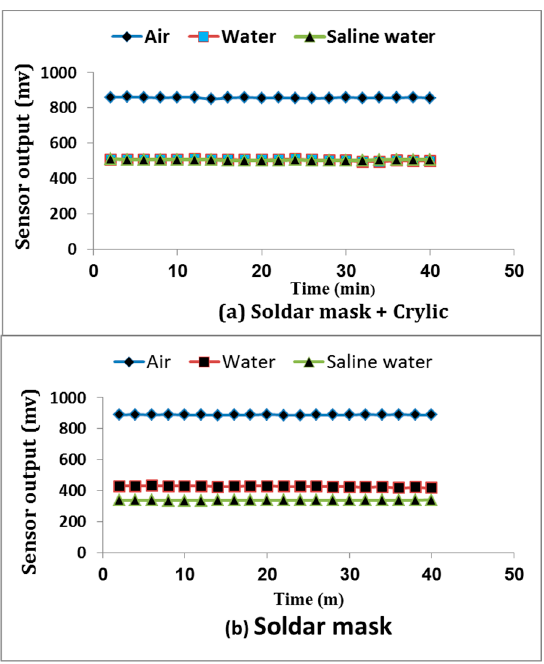
Figure 4. Sensitivity response of the designed sensor with both tested coating materials: ( a ) solder mask + acrylic; ( b ) solder mask measured in air, fresh water, and saline water.